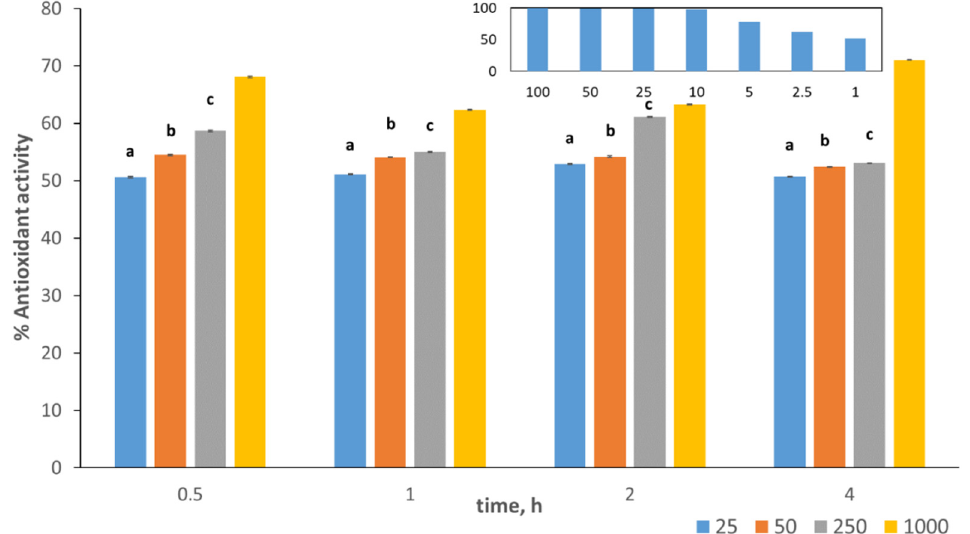
Figure 1. Antioxidant activity (%) of different concentrations of the algal extracts (25, 50, 250, and 1000 µg/mL) obtained after various extraction times, shown in different colors. All experiments were done in triplicate, and values are expressed as mean values ± SD. Groups with the same letters are insignificantly different at p = 0.05. The inserted figure shows the % antioxidant activity of different concentrations of ascorbic acid as a reference.